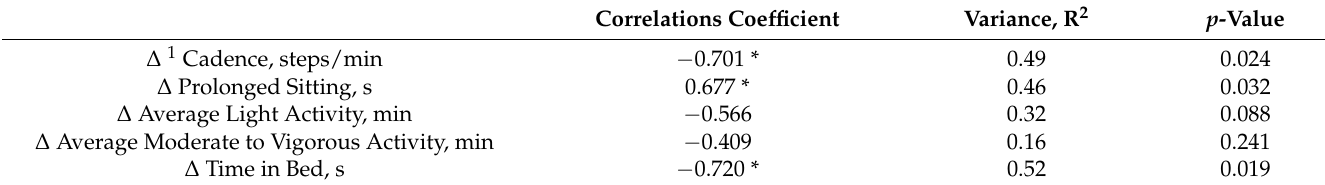
Table 3. Association with the change in depression measured using Spearman correlation analysis.